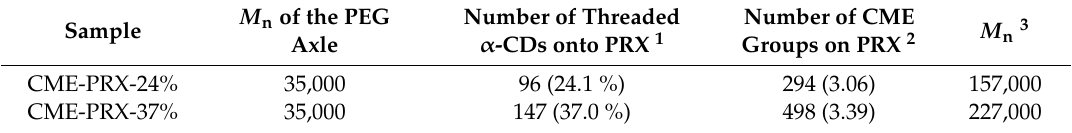
Table 1. Characterization of carboxymethyl ether group-modified polyrotaxanes (CME-PRXs). M n of the PEG Number of Threaded Number of CME Sample M n 3 α -CDs onto PRX 1 Axle Groups on PRX 2 CME-PRX-24% 35,000 96 (24.1 %) 294 (3.06) CME-PRX-37% 35,000